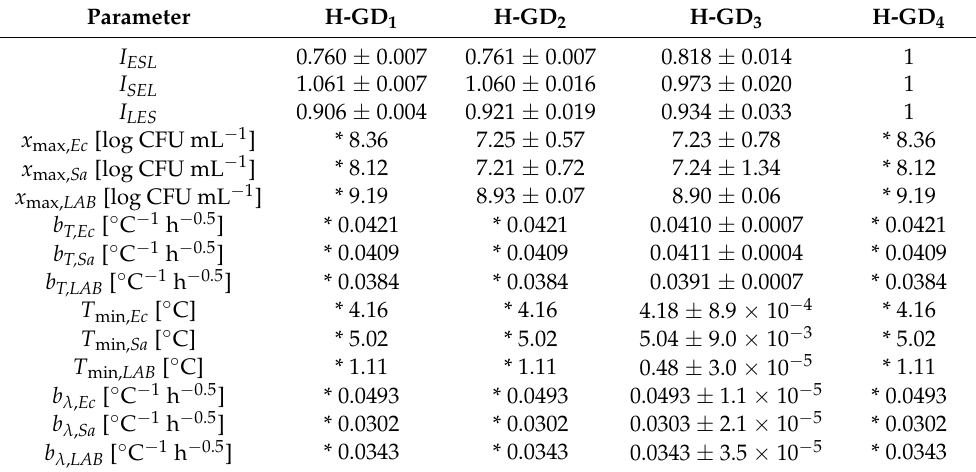
Table 7. Parameters of the H-GD models with 95% confidence limits determined by the one-step analysis method used for co-culture growth prediction of S. aureus (Sa), E. coli (Ec), and Fresco (LAB) in milk.